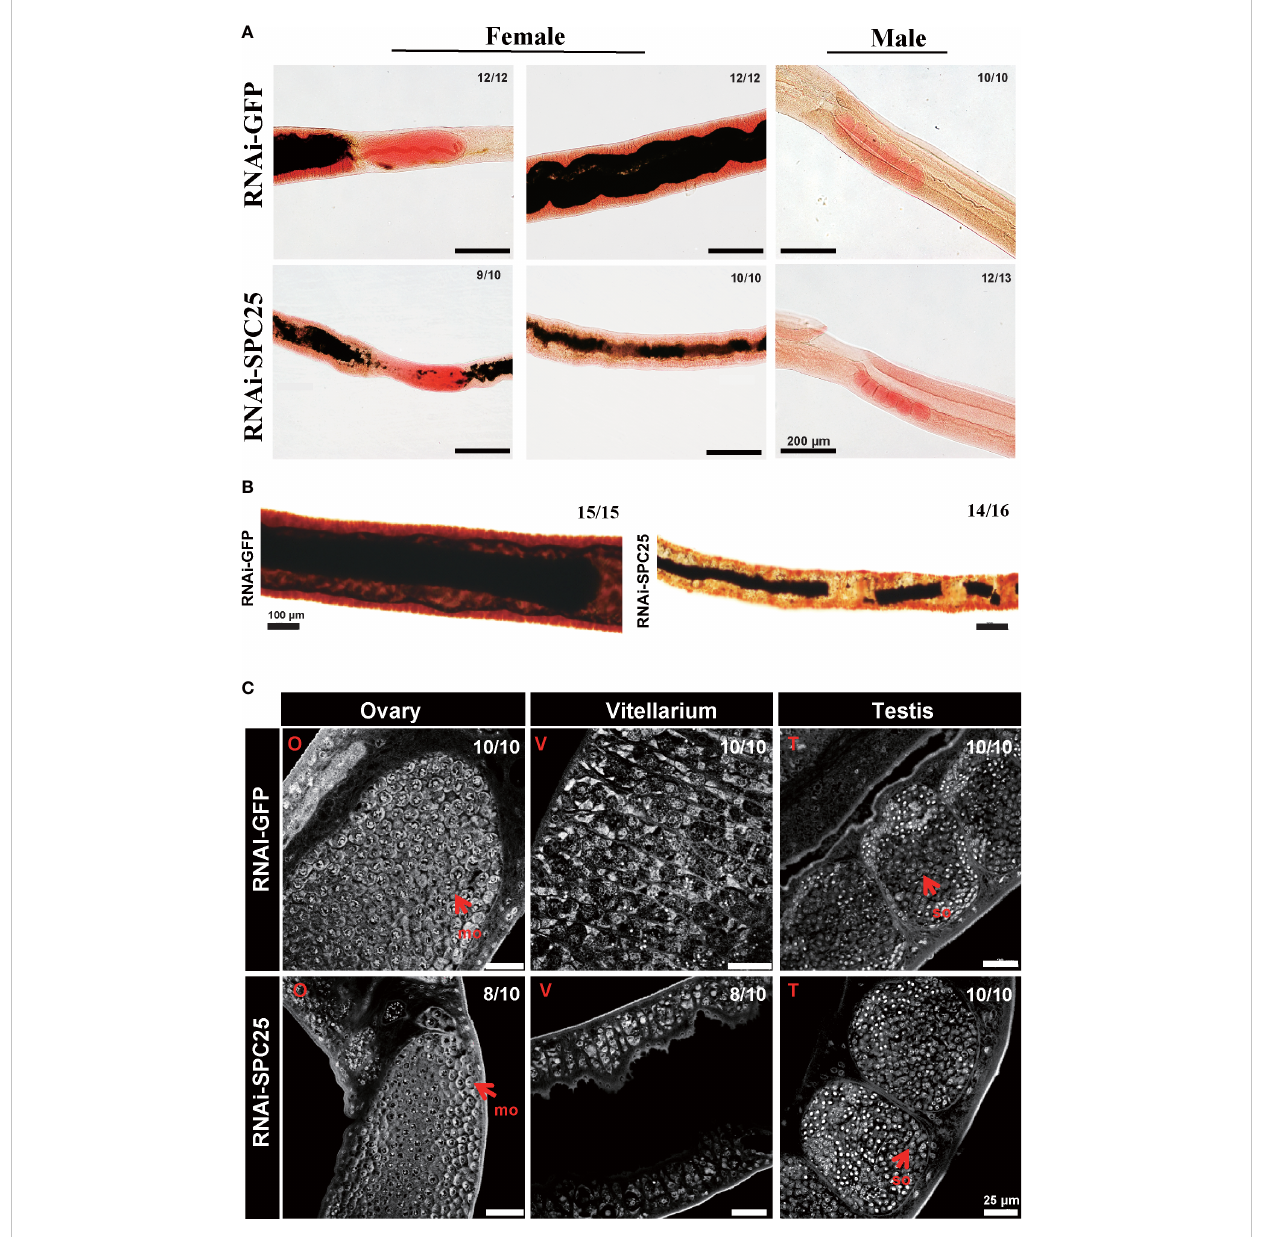
FIGURE 5 Morphological analysis of the reproductive organ in recovered RNAi-SPC25 worms at 42 dpi. (A) Microscopy images of carmalum staining of S. japonicum . (B) Microscopy images of Fast Blue B staining female worms. Positive Fast Blue B staining indicates mature vitelline cells. (C) Confocal laser scanning micrographs documenting morphological changes in the reproductive organs of RNAi-SPC25 group and control group worms. T, testis; O, ovary; V, vitellarium; P, intestinal pigment deposition; mo, mature oocytes; io, immature oocytes; so, spermatocytes. X/Y: number of worms with the same phenotype/number of worms analyzed in one biological